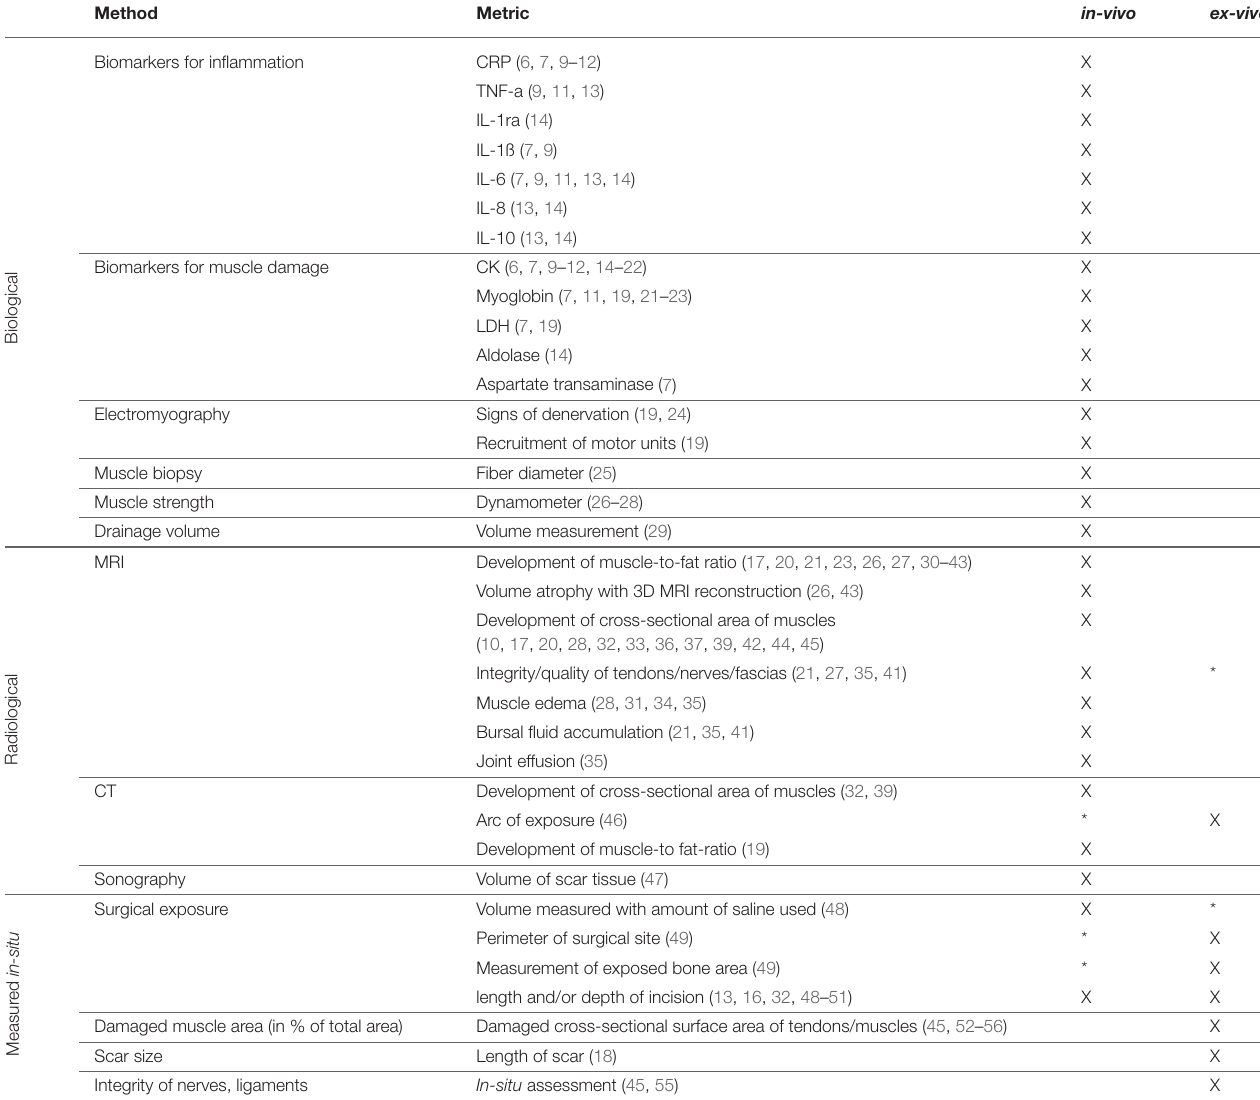
TABLE 2 | An overview of the reviewed metrics.